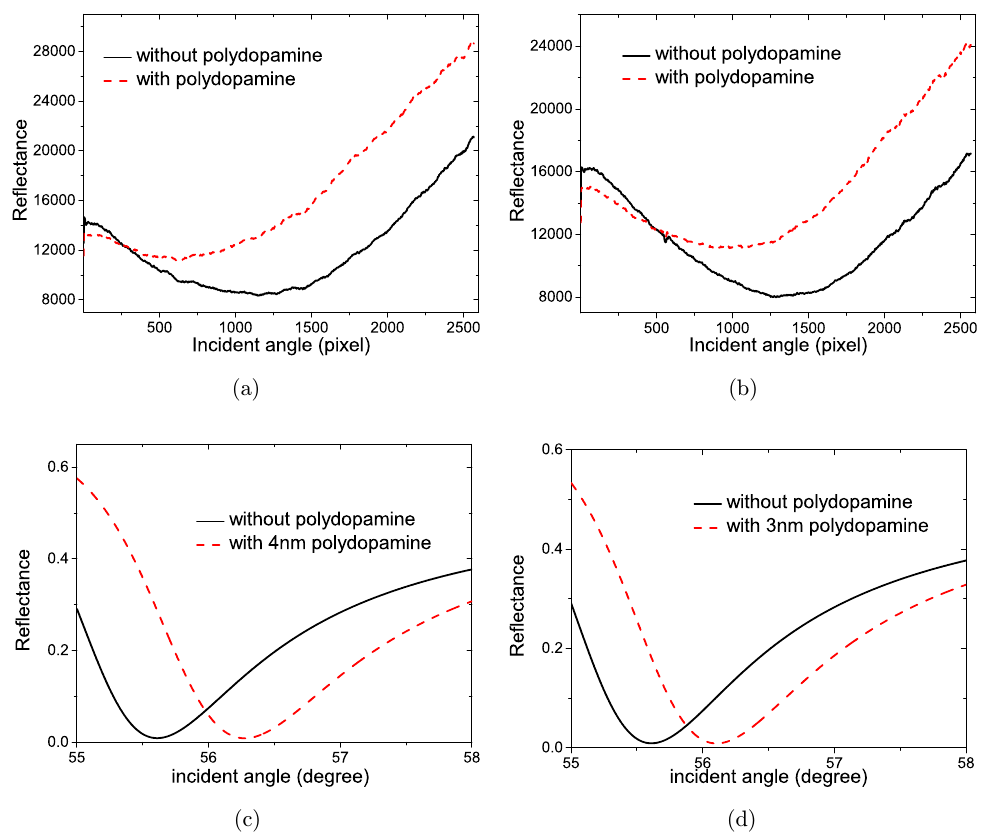
Fig. 4. (a) The measured re°ectance spectra without and with polydopamine in the reference channel. (b) The measured re°ec- tance spectra without and with polydopamine in the detection channel. (c) The SPR calculated re°ectance spectra without and with 4nm polydopamine ¯lm. (d) The SPR calculated re°ectance spectra without and with 3 nm polydopamine ¯lm.